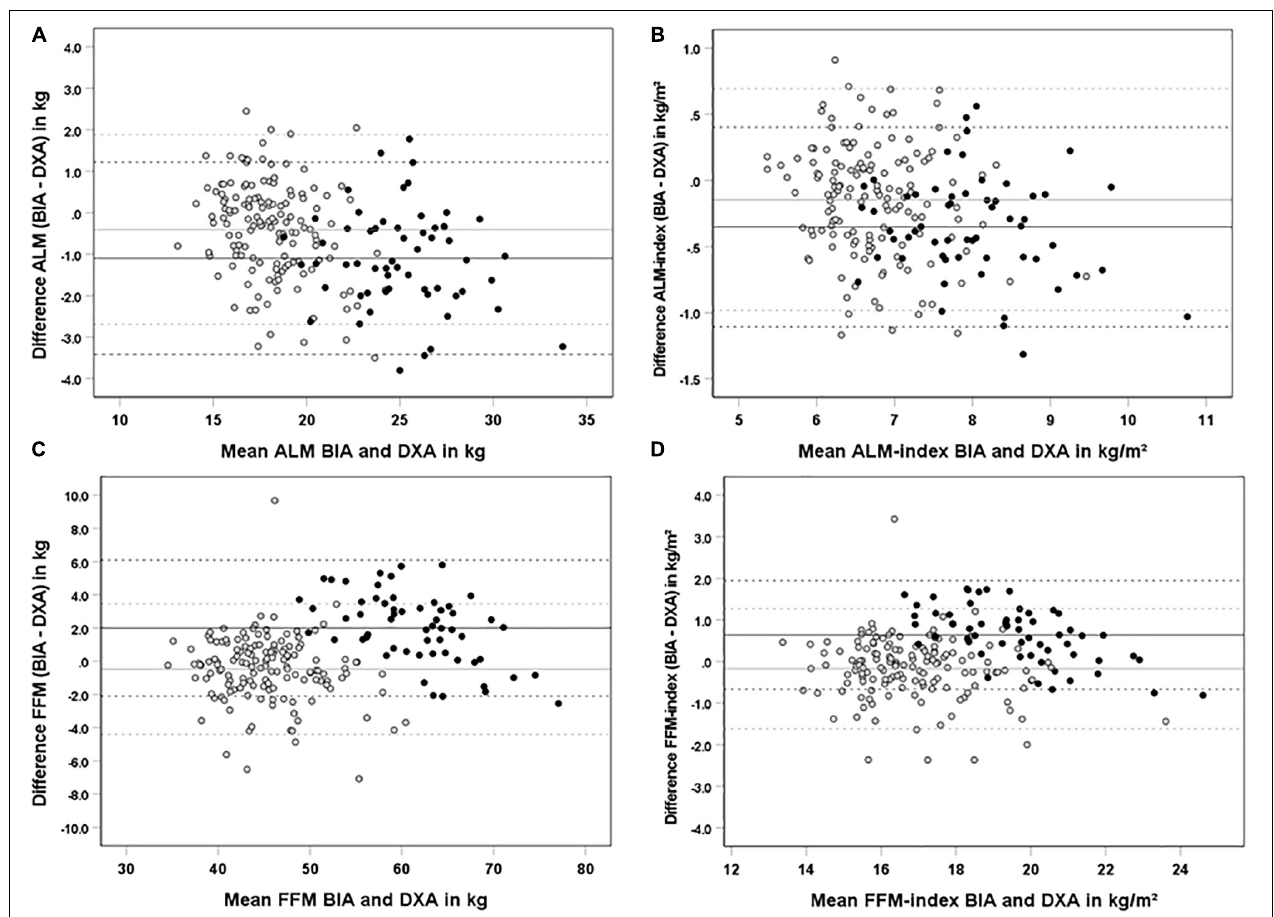
FIGURE 3 | Bland-and-Altman plots for agreement of BIA and DXA for ALM (A) , ALM-index (B) . FFM (C) and FFM-index in kg/m 2 (D) in 202 subjects (58 males. 144 females). Black dots and lines represent males, and gray dots and lines females. Continued lines represent the mean bias, dashed lines represent the limits of agreement [mean ± (1.96 × SD)]. Proportional bias is reported when the slope of the regression line was significant. (A) females R 2 = 0.08 | Y = 2.41–0.16X, p < 0.001); (B) females R 2 = 0.03 | Y = 0.63–0.12X, p = 0.035); (C) males R 2 = 0.28 | Y = 13.1–0.18, p < 0.001); (D) males R 2 = 0.38 | Y = 5.29–0.24, p <